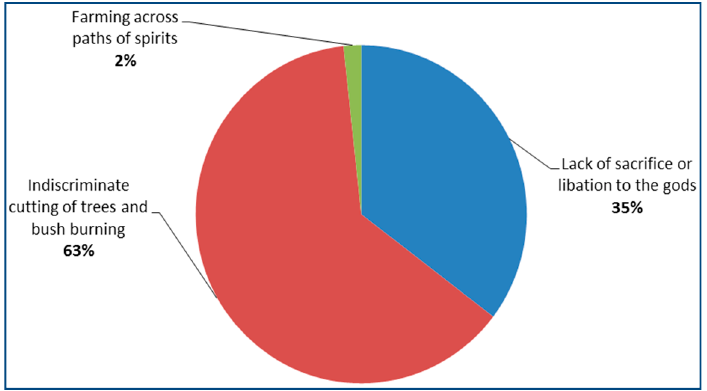
Figure 3. Reasons for Perceived Changes in the Rainfall Pattern. Source: Author’s construct based on field survey results (2016).